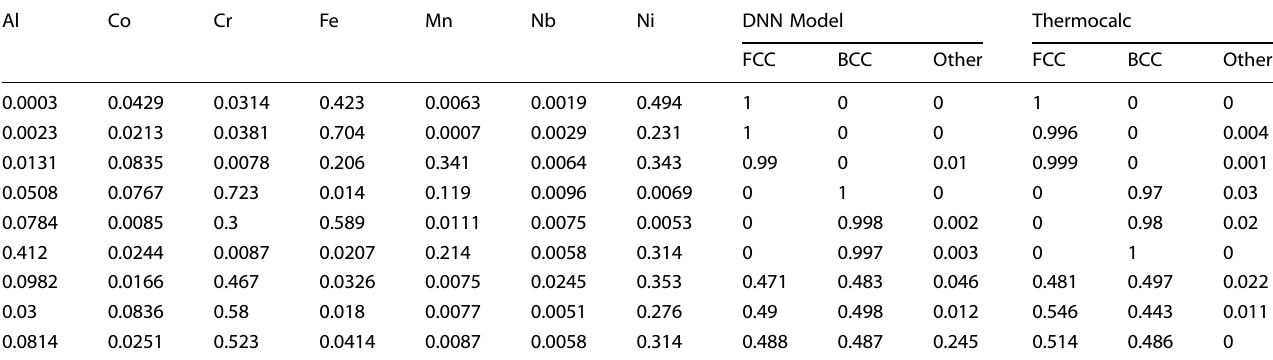
Table 1. BO optimized compositions for each optimization case. Bayesian optimization results for the optimization tasks: Full FCC, full BCC, and mid- point composition of 0.5,0.5 with simple phases. Al